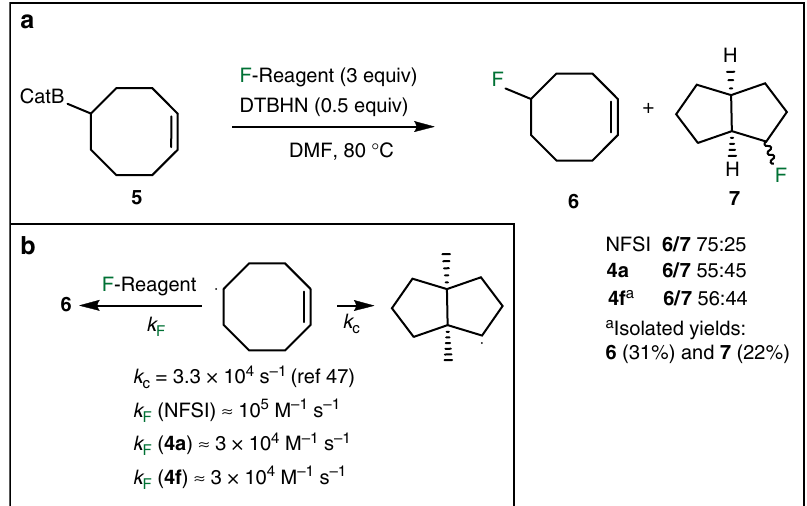
Fig. 5 Rate constant determination using the ( Z )-cyclooct-1-en-5-yl radical clock. a Fluorination of boronate 5 with NFSI, 4a and 4f affords mixtures of mono and bicyclic fl uorides 6 and 7 . b Estimated rate constants for the radical fl